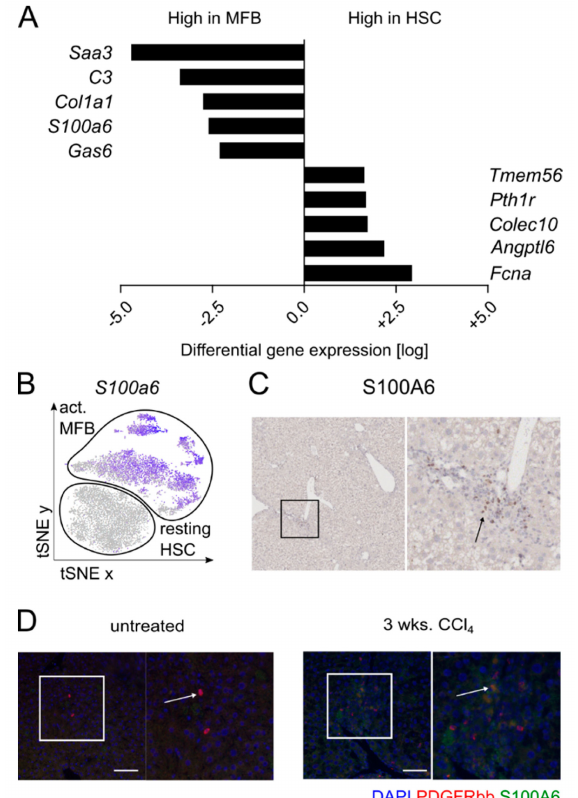
Figure 2. The S100 calcium binding protein A 6 (S100A6) expression marks activated myofibroblasts. ( A ) Di ff erential gene expression analysis of HSCs versus MFB, showing the top five genes upregulated in both groups. ( B ) t-SNE plot of relative gene expression of S100A6, based on scRNASeq analyses from normal and fibrotic mouse livers. ( C ) Representative image of immunohistochemistry staining for S100A6 in CCl 4 -treated fibrotic liver. ( D ) Representative images of immunofluorescence co-staining for PDGFR- β (red) and S100A6 (green) on untreated and CCl 4 -treated fibrotic liver. Nuclei are stained with DAPI (4 (cid:48) ,6-diamidino-2-phenylindole, blue). Scale bar represents 100 µ